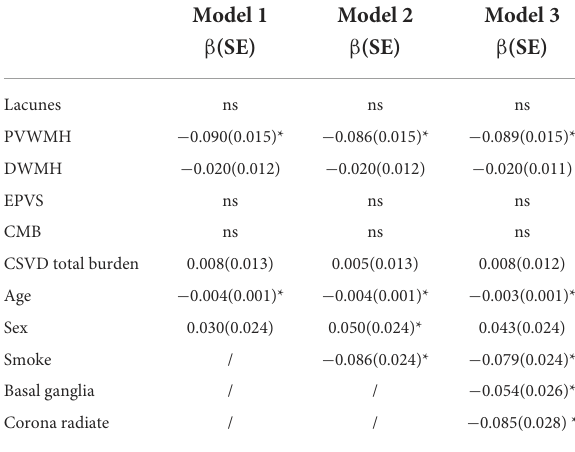
TABLE 4 Independent predictive analysis of walking speed by CSVD in patients with minor stroke.